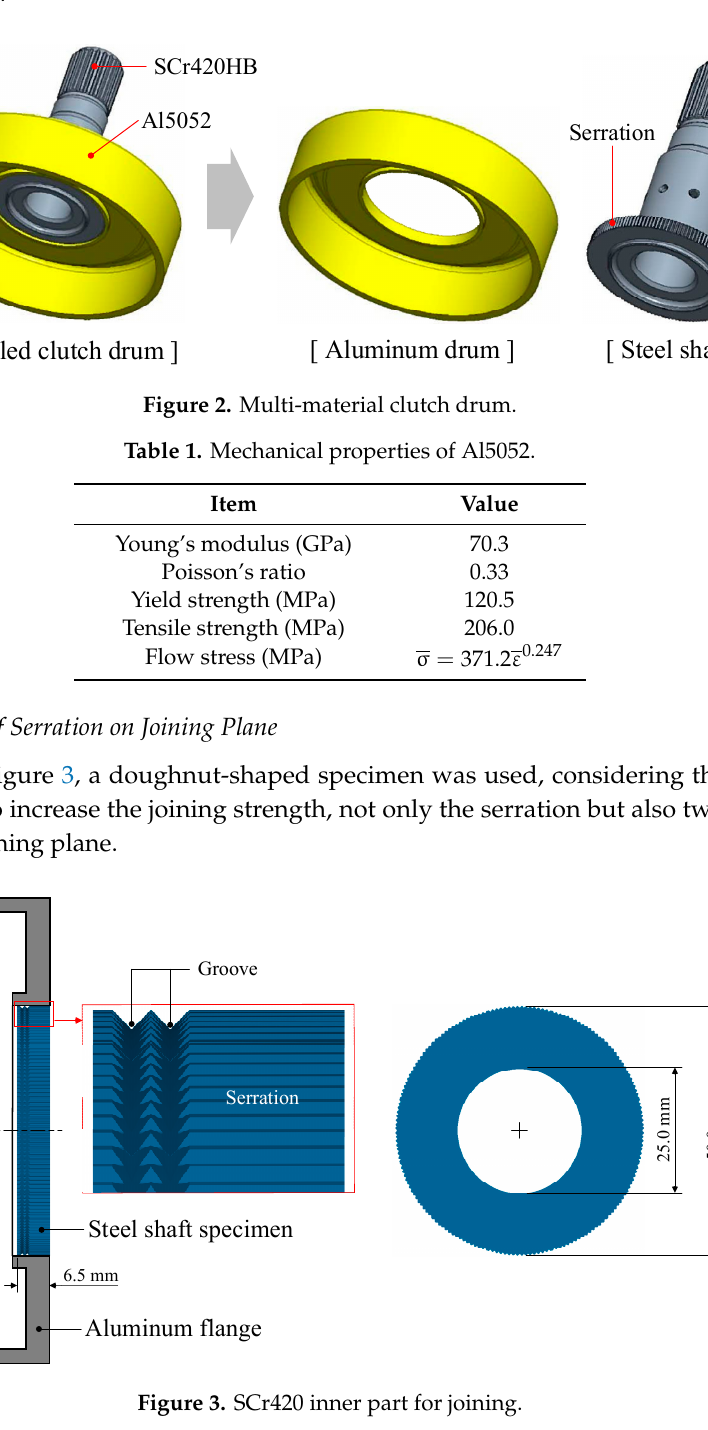
Figure 3. SCr420 inner part for joining.